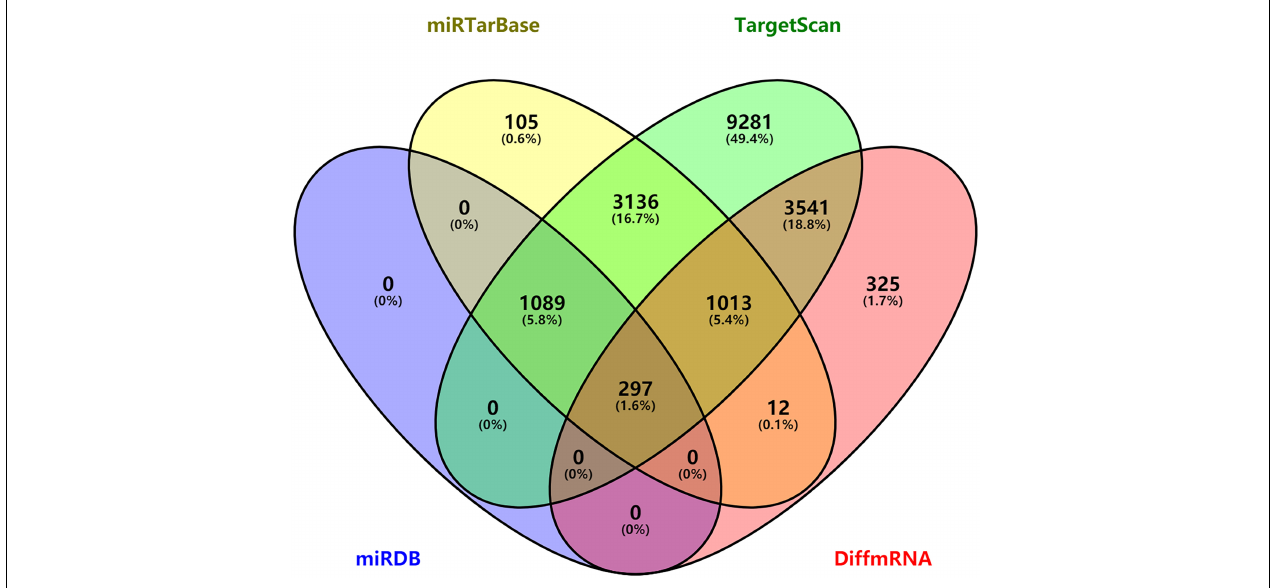
FIGURE 3 | Venn diagram showing 297 differentially expressed mRNAs targeted by miRNAs via intersection of prediction results of TargetScan, miRDB, and miRTarBase database.